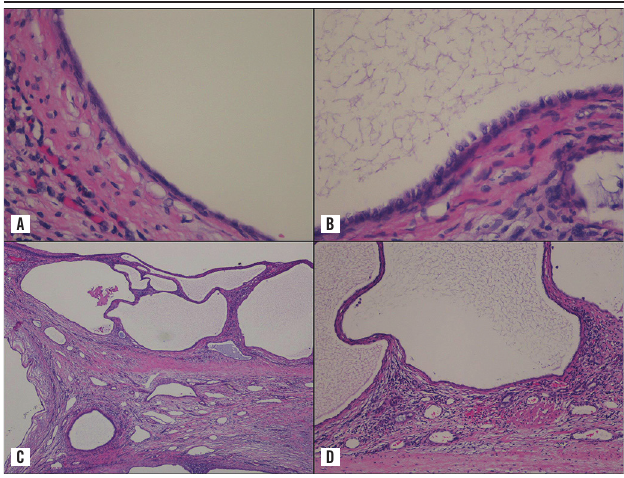
A B C figurE 3 − The cysts were lined by cubic or flat epithelia, sometimes with hobnail cells and prominent nucleoli, but without atypia or mitotic activity (3A and 3B); the cyst wall was composed of fibrous tissue, with rare, but well-developed renal tubules with mild lymphoplasmacytic inflammation, without blastema and muscle/chondroid mesenchymal components (3C and 3D)